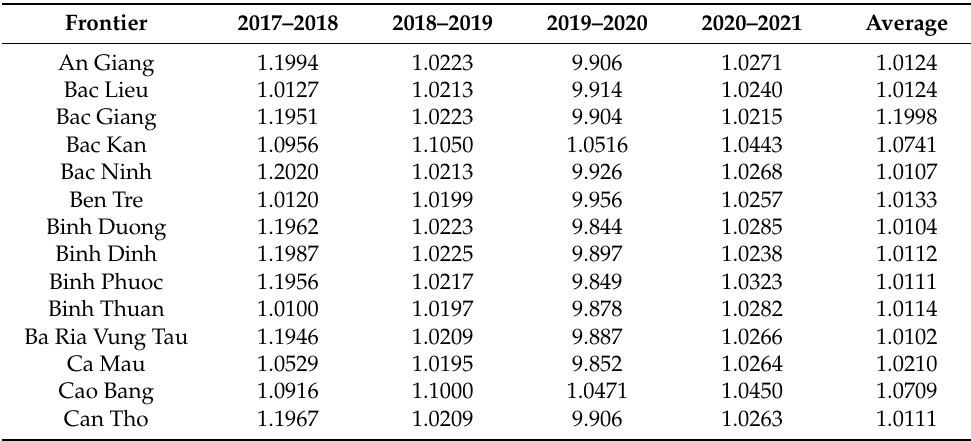
Table A2. Frontier-shift Index